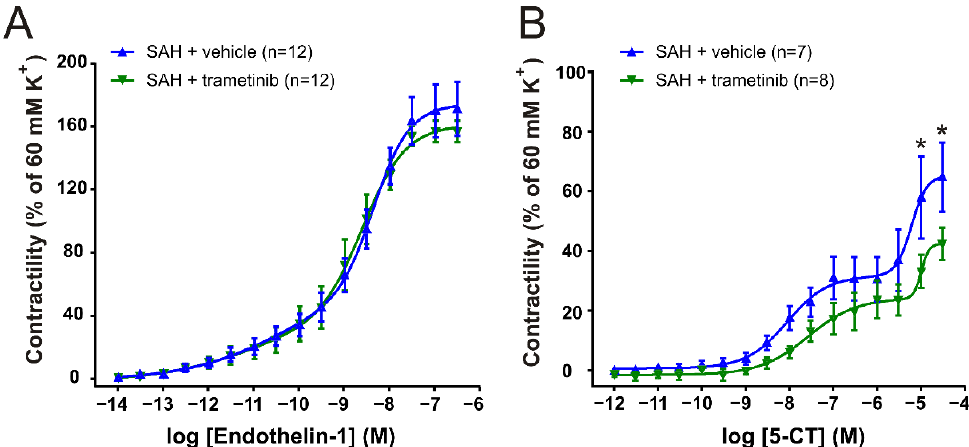
Figure 4. Comparison of trametinib and vehicle treatment on contractility in the MCA ( A ) Cumulative concentration – response curves to ET-1 (10 −14 – 10 −7 M). ( B ) Cumulative concentration – response curves to 5-CT (10 −12 – 3·10 −5 M). Data are shown as mean ± SEM, with statistics calculated using two-way ANOVA followed by Bonferroni post-test, * p < 0.05.